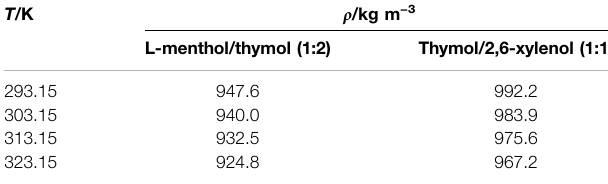
TABLE 2 | Density of eutectic mixtures measured in this work a . T /K ρ /kg m −